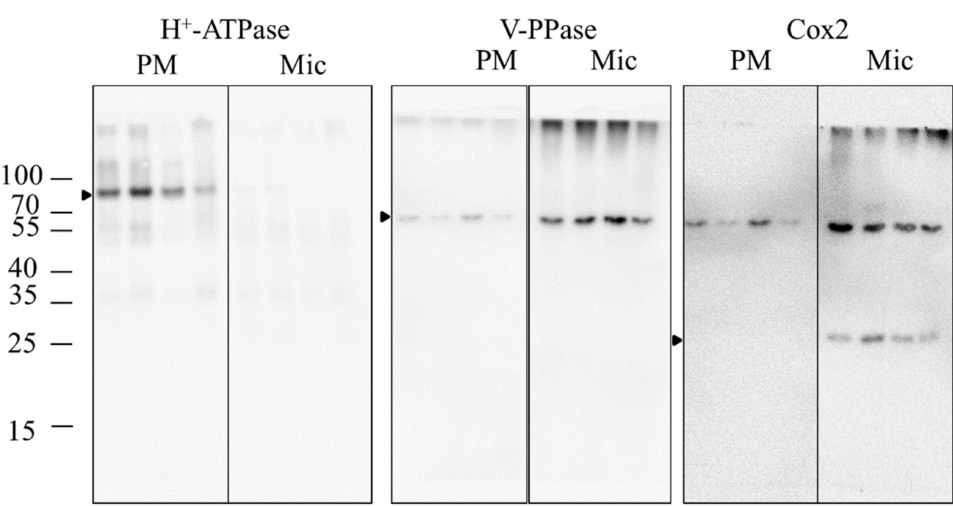
Figure 7. Purity verification of PM preparations. Plasma membrane and corresponding microsomal protein samples (5 µ g each) were load on 11 % polyacrylamide gels and transferred to PVDF mem- brane. Following antibodies were used to detect the PM specific H + -ATPase of plants (H + -ATPase, 1:5000), the vacuolar H + -pyrophosphatase (V-PPase, 1:2500), and the mitochondrial cytochrome c oxidase (Cox2, 1:1000). Shown are two representative